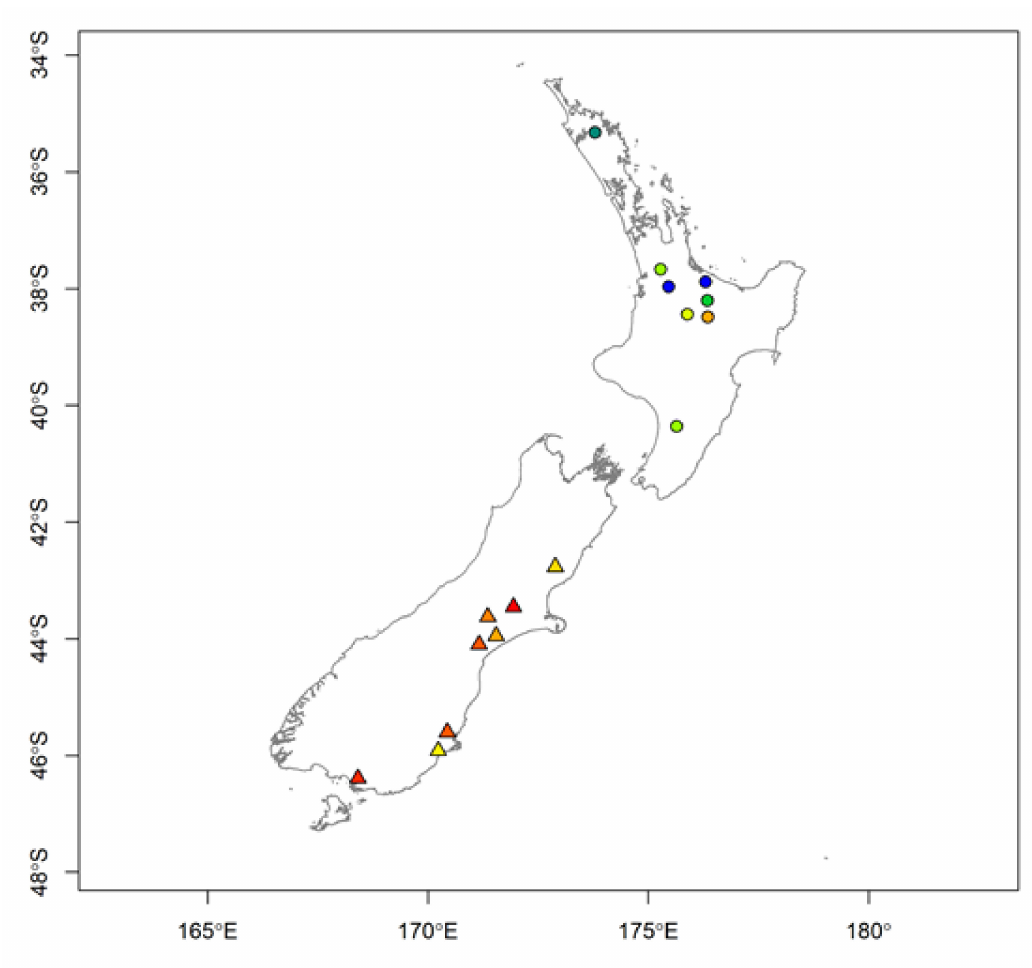
Figure 4. PCA score-location map of South Island and North Island dairy farms (16 sampling locations; using four variables— δ 13 C, δ 15 N, δ 2 H and δ 18 O) which uses the same system of colours that is used